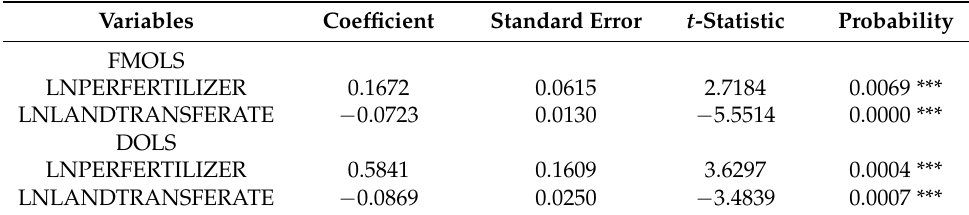
Table 5. The results of FMOLS, DOLS estimation techniques: full panel.